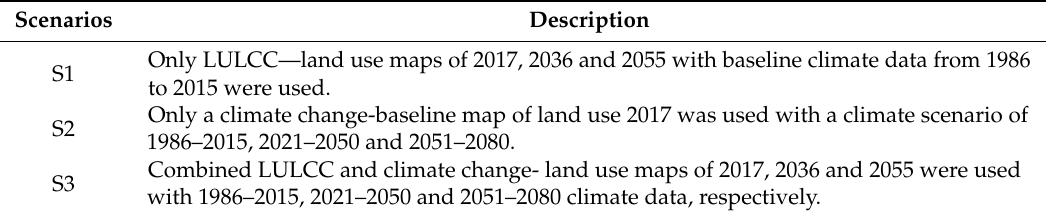
Table 1. Detail land use / land cover and climate change